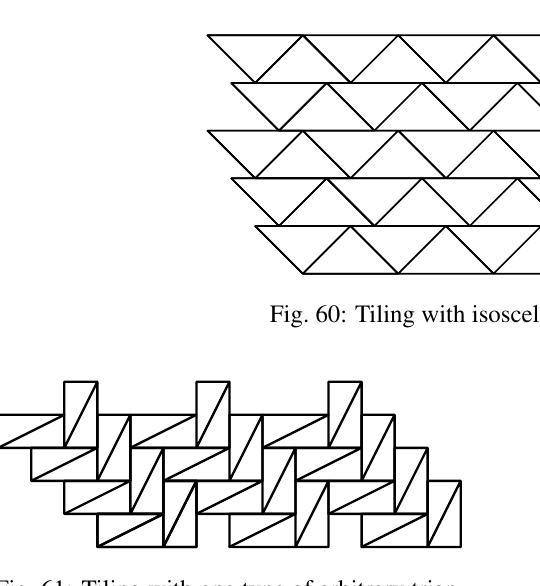
Fig. 61: Tiling with one type of arbitrary trian- gle. Two triangles in the vertex corona share an entire long edge, the other two share part of a medium edge.